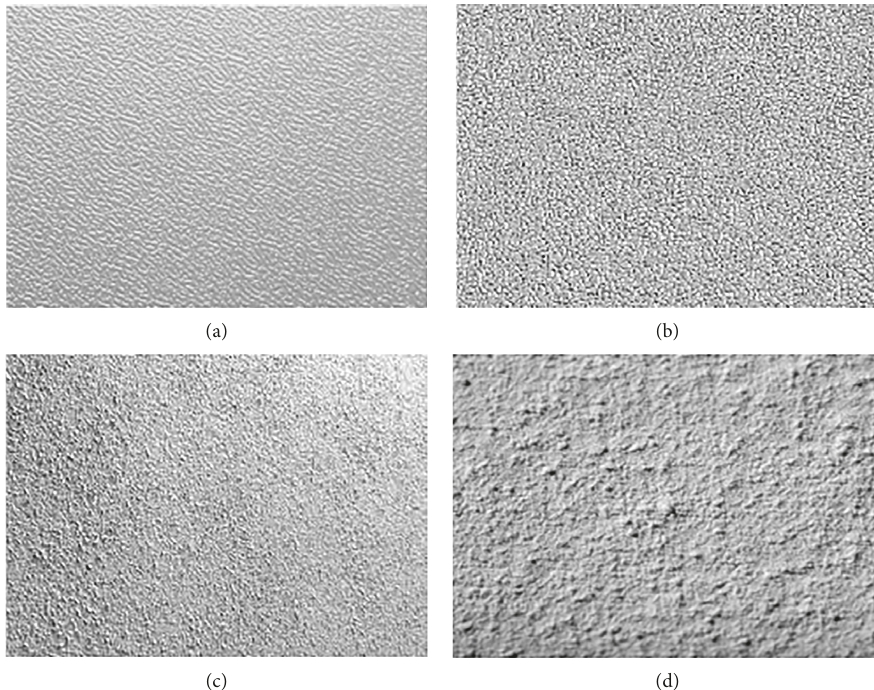
Figure 1: Photographic images of the four PMMA sheets prepared by shot-blasting techniques before the dynamic friction tests: (a) PMMA1, (b) PMMA2, (c) PMMA3, and (d)